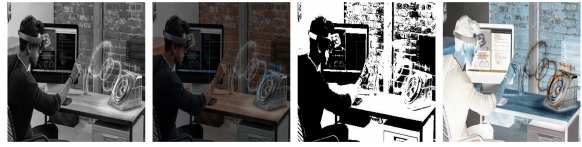
Fig. 6. Recognition result of No-beep test set